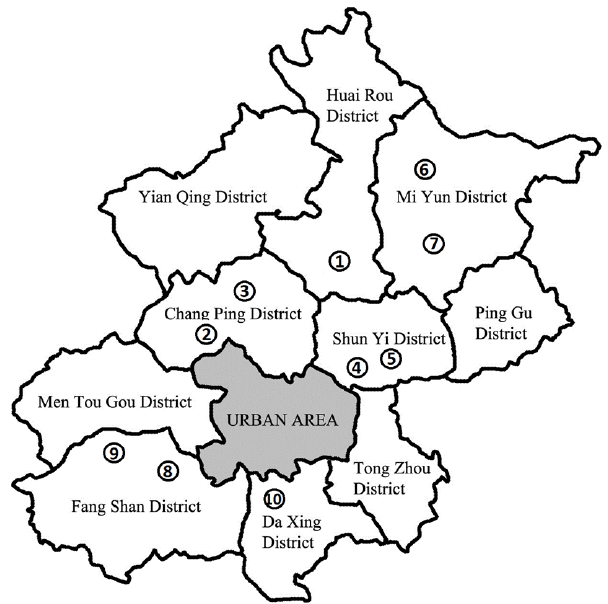
Figure 1. Locations of RWHs studied within Beijing.